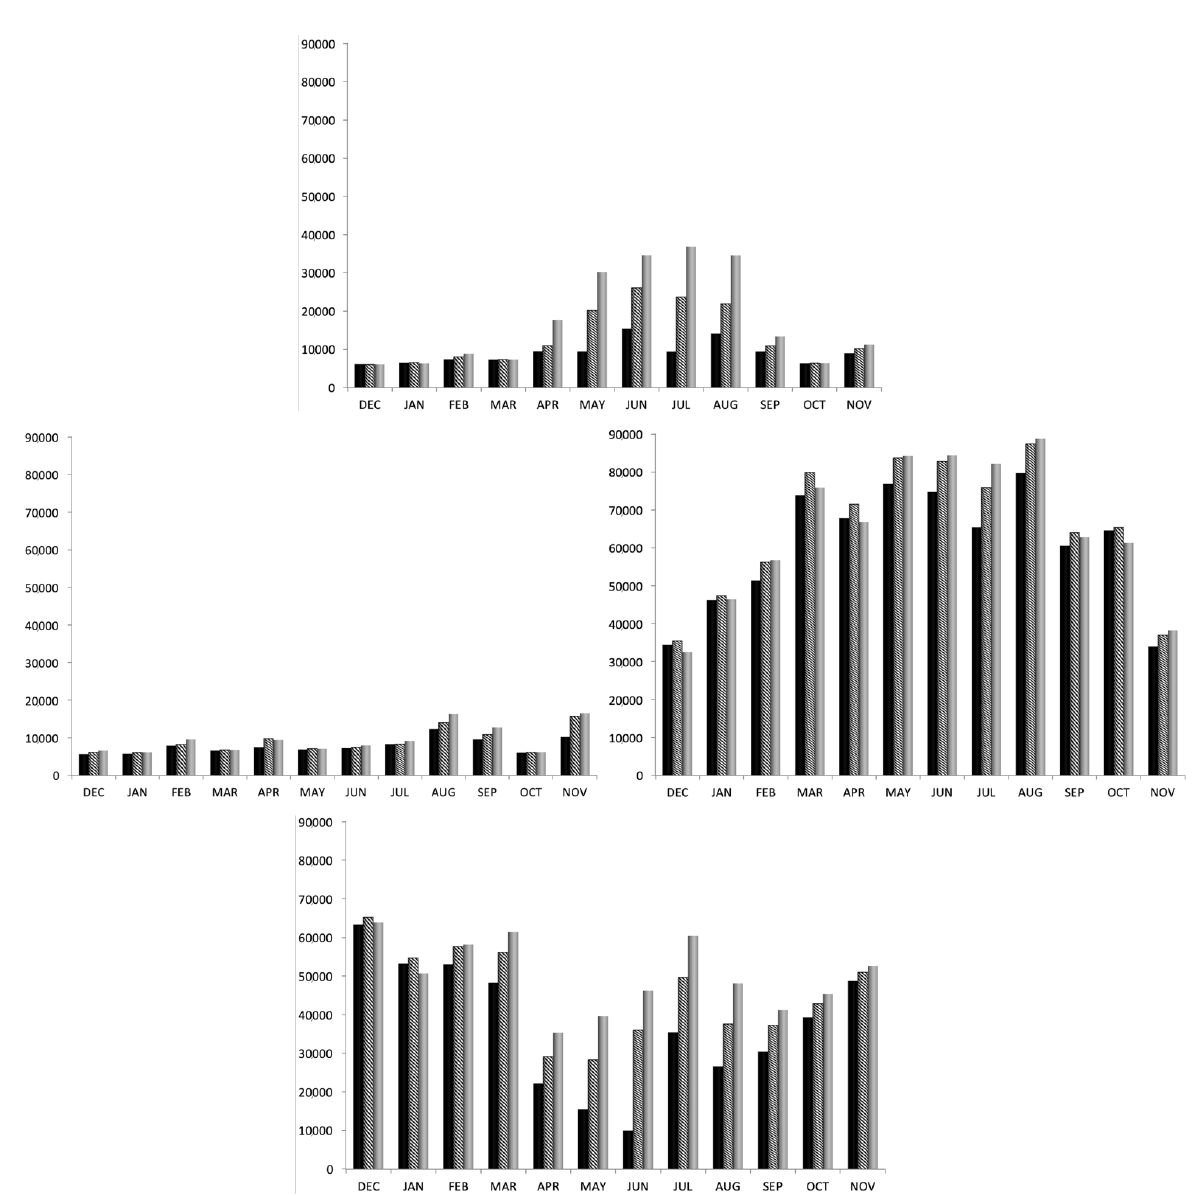
Figure 6. EDIs calculated depending on the season (from December 2018 to November 2019); orientation of north ( top ), east ( right ), south ( bottom ), and west ( left ); and elevation from the horizontal level of 15° (black), 30° (striped), and 45° (grey).